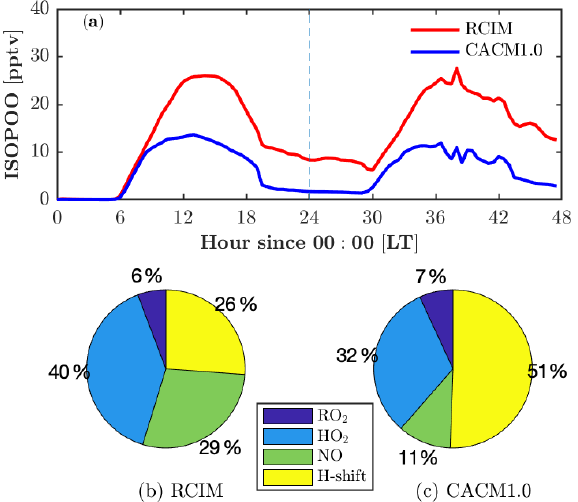
Figure 5. Fate of isoprene hydroxy peroxy radicals (ISOPOO) in RCIM and in CACM1.0. (a) Diurnal profiles of ISOPOO concentra- tions in RCIM and CACM1.0. (b, c) Fraction of daytime-averaged (12:00–14:00LT) production rates of ISOPOO through reactions with peroxy radicals (RO 2 ), hydroperoxy radicals (HO 2 ), nitric ox- ide (NO), and H-shift isomerization in RCIM and CACM1.0.